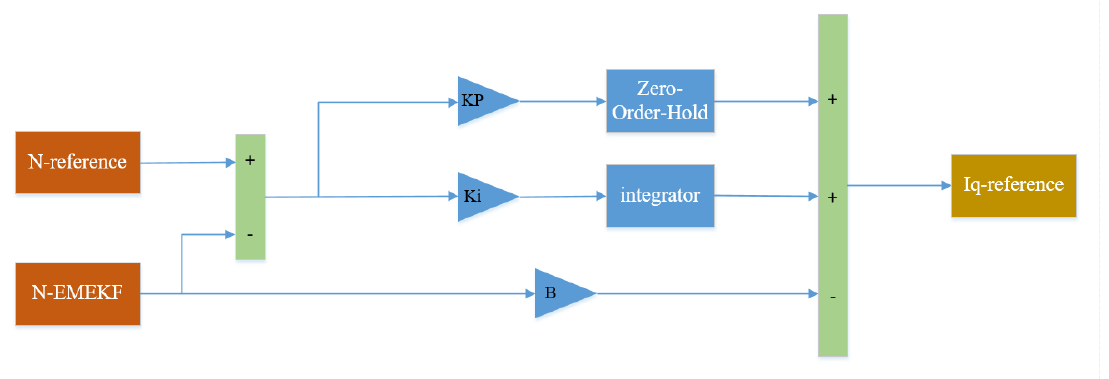
Figure 3. PMSLM vector control structure based on AMEKF.